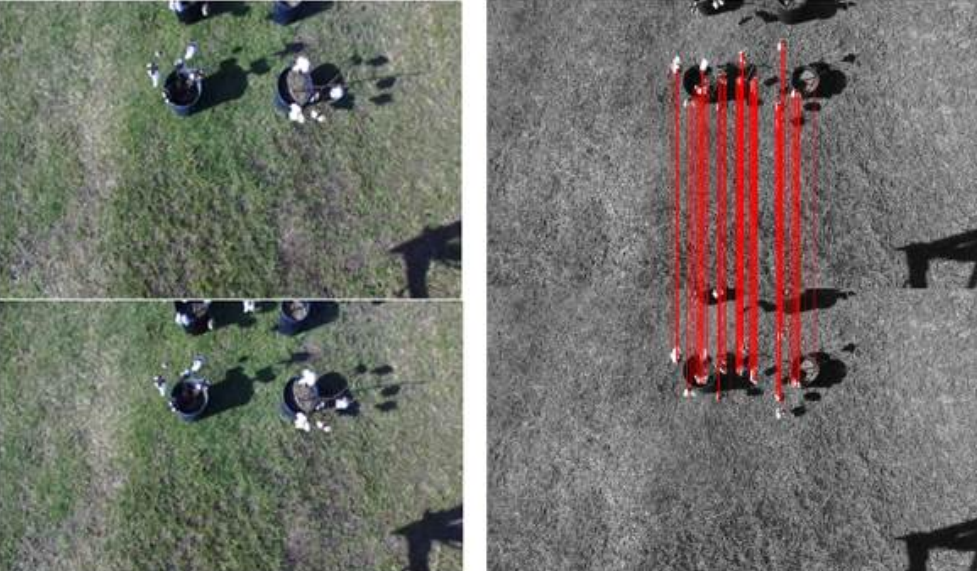
Figure 8. Two consecutive images collected from the ZED camera and the moving rover (left images) and matching features obtained using the oriented FAST and rotated BRIEF (ORB) algorithm and the homograph random sample consensus (RANSAC) algorithm (right image).